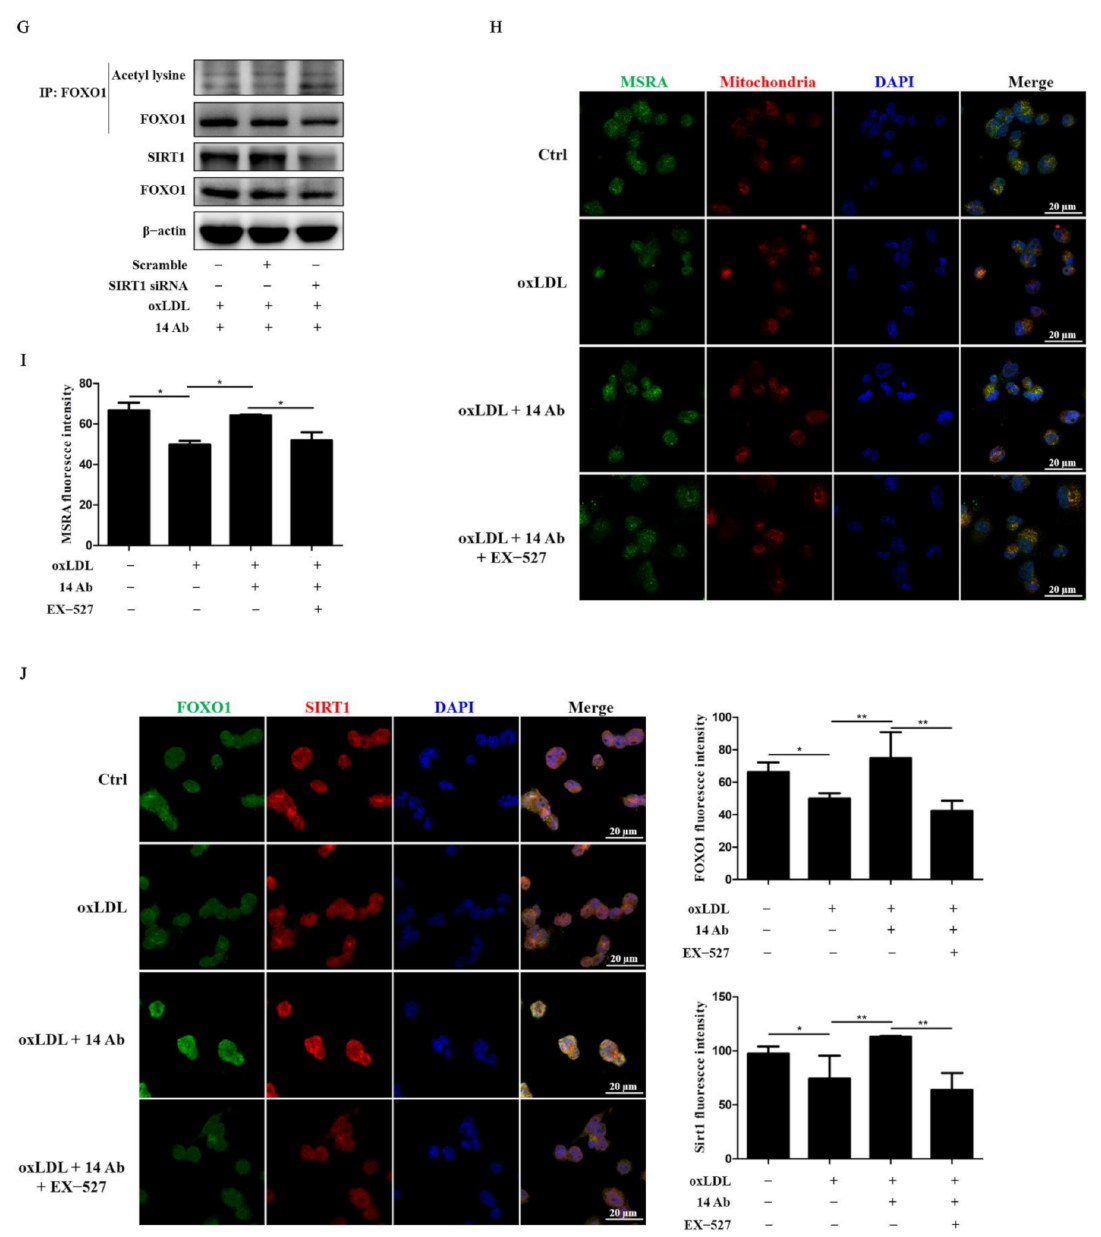
Figure 5. Recombinant humanized IgG1 antibody ameliorates oxLDL-induced apoptosis via mod- ulation of SIRT1-dependent FOXO1 deacetylation. ( A , B ), THP-1 cells were treated with oxLDL (50 µ g/mL) along with or without the recombinant humanized IgG1 antibody (14 Ab, 100 µ g/mL) for 48 h, and then the cells were collected for immunoprecipitation to determine the acetylation modification of FOXO1; IgG was used as an isotype control (n = 4). ( C ) THP-1 cells were treated with oxLDL (50 µ g/mL) with or without the recombinant humanized IgG1 antibody (14 Ab, 100 µ g/mL) for 48 h, and then the cells were collected for separation of cytoplasmic and nuclear proteins and to determine the acetylation modification of FOXO1 as well (n = 4). ( D ) THP-1 cells were pretreated with SIRT1 inhibitor EX-527 (10 µ M) for 30 min, or following treatment with oxLDL (50 µ g/mL) along with or without the recombinant humanized IgG1 antibody (14 Ab, 100 µ g/mL) for 48 h to measure the protein expression of SIRT1, FOXO1 and MSRA (n = 4). ( E , F ), THP-1 cells were pretreated with SIRT1 inhibitor EX-527 (10 µ M) for 30 min, followed by treatment with oxLDL (50 µ g/mL) with the recombinant humanized IgG1 antibody (14 Ab, 100 µ g/mL) or treated with oxLDL alone or with the recombinant humanized IgG1 antibody (14 Ab, 100 µ g/mL) for 48 h to measure the